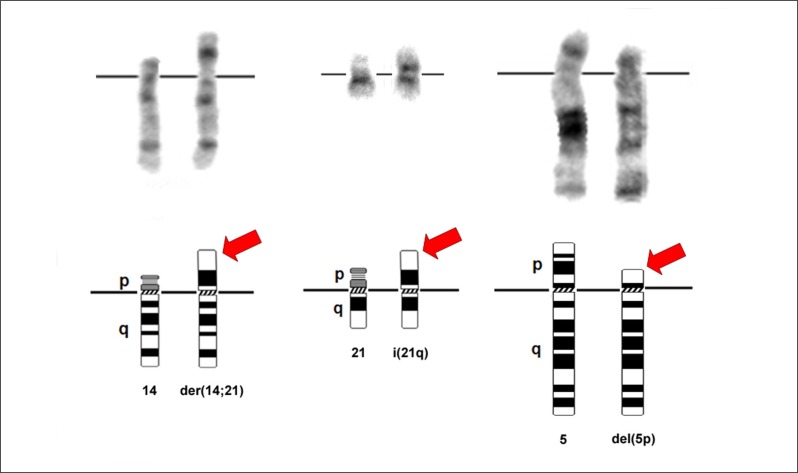
Cariótipo parcial por bandas GTG (banda G por tripsina e Giemsa) e
ideogramas evidenciando, respectivamente, uma translocação Robertsoniana
entre os cromossomos 14 e 21 [der(14;21)], um isocromossomo do braço longo
(q) do cromossomo 21 [i(21q)] e uma deleção parcial e intersticial do braço
curto do cromossomo 5 [del(5p)]. As duas primeiras alterações representam
formas associadas à síndrome de Down e a terceira, à síndrome do
Cri-du-Chat